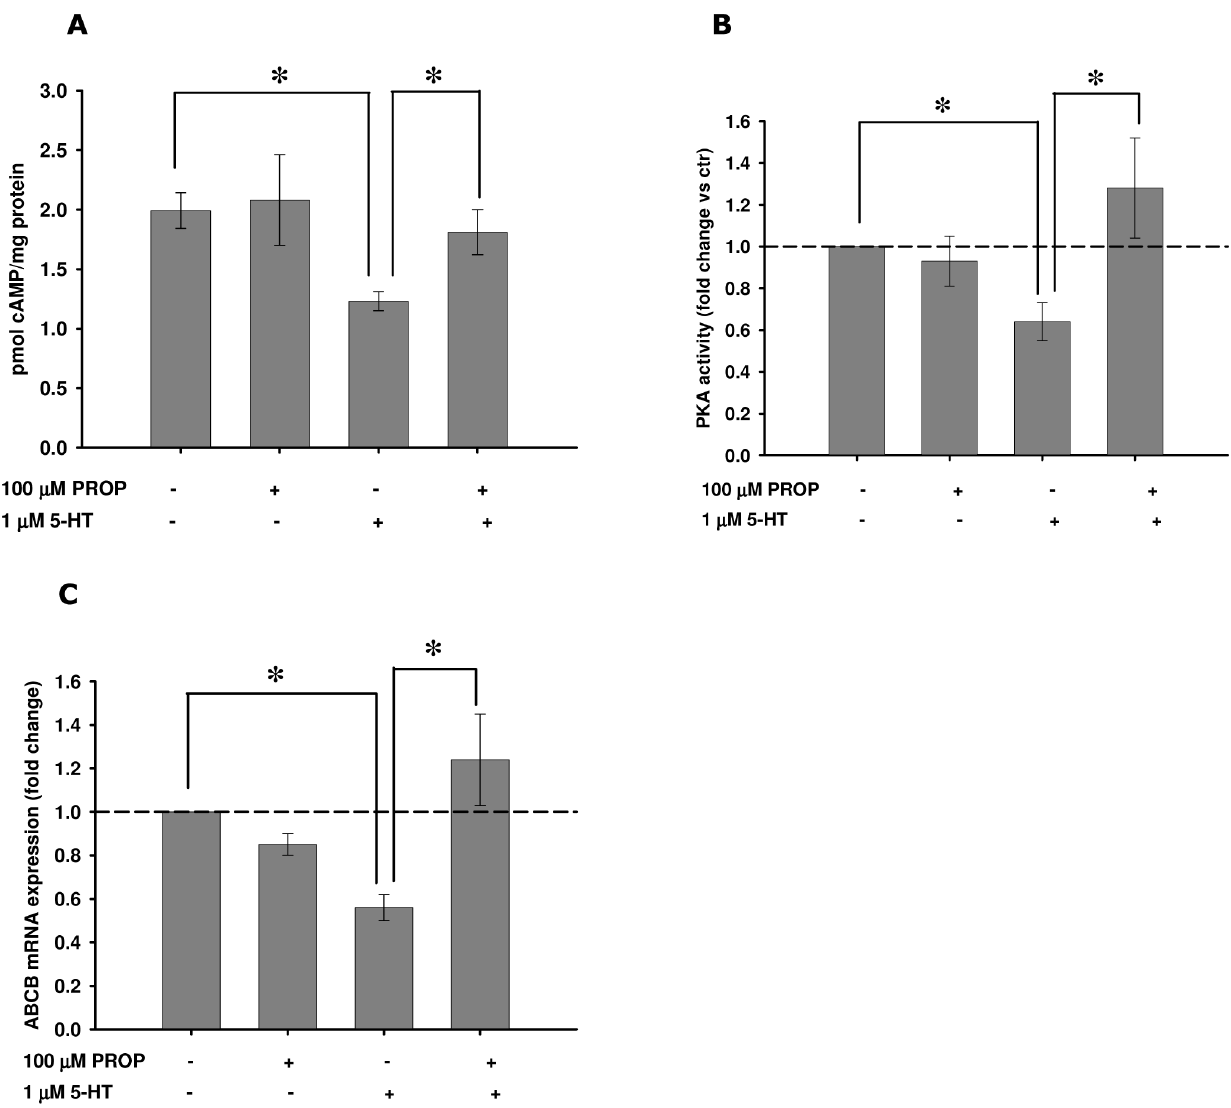
Figure 3. Effects of PROP pre-incubation on 5-HT modulated parameters in mussel haemocytes incubated invitro . (A) cAMP content; (B) relative PKA activities; (C) relative ABCB mRNA expression; (D) relative 5-HT 1 mRNA expression. All biological endpoints were assessed after 1 h of exposure to 1 m M 5-HT in the presence/absence of a 15-min pre-incubation with 100 m M PROP. Data are derived from three independent experiments (mean 6 SEM); *p , 0.05 between pairs of samples. Basal PKA activity = 1.12 6 0.17 nmol/min/mg protein.